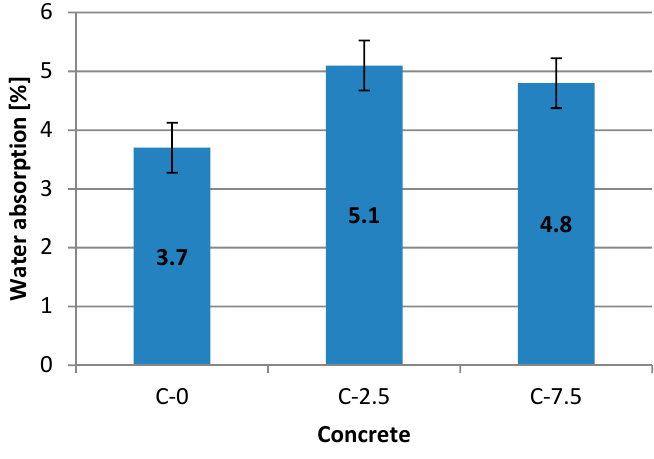
Figure 5. Water absorption of 10 cm cubes. Table 9. Elementary statistics for water absorption.